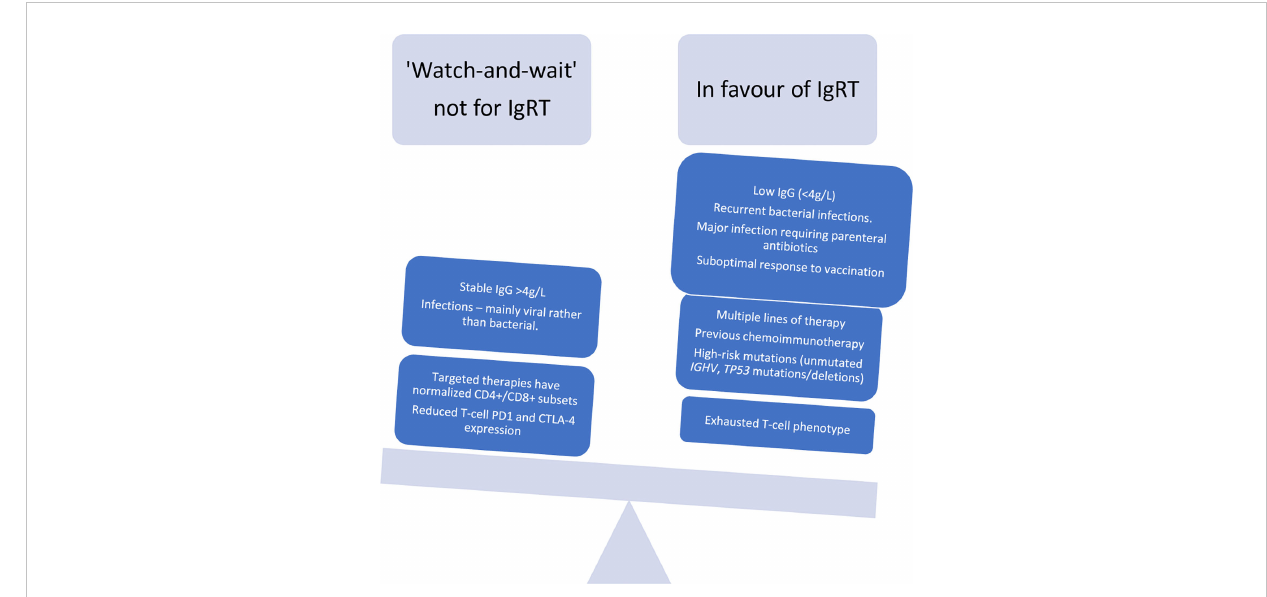
FIGURE 2 A re-look at indications for immunoglobulin replacement therapy in CLL in the era of targeted